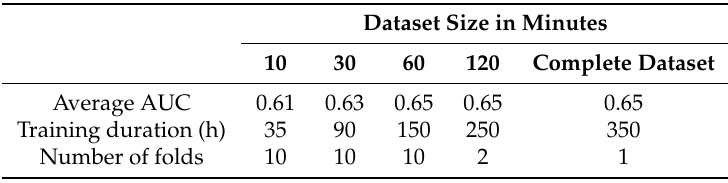
Table 4. Average AUC, training duration, and number of folds obtained when applying the ConvLSTM model to different dataset sizes. The dataset was cut into three subsets at the subject